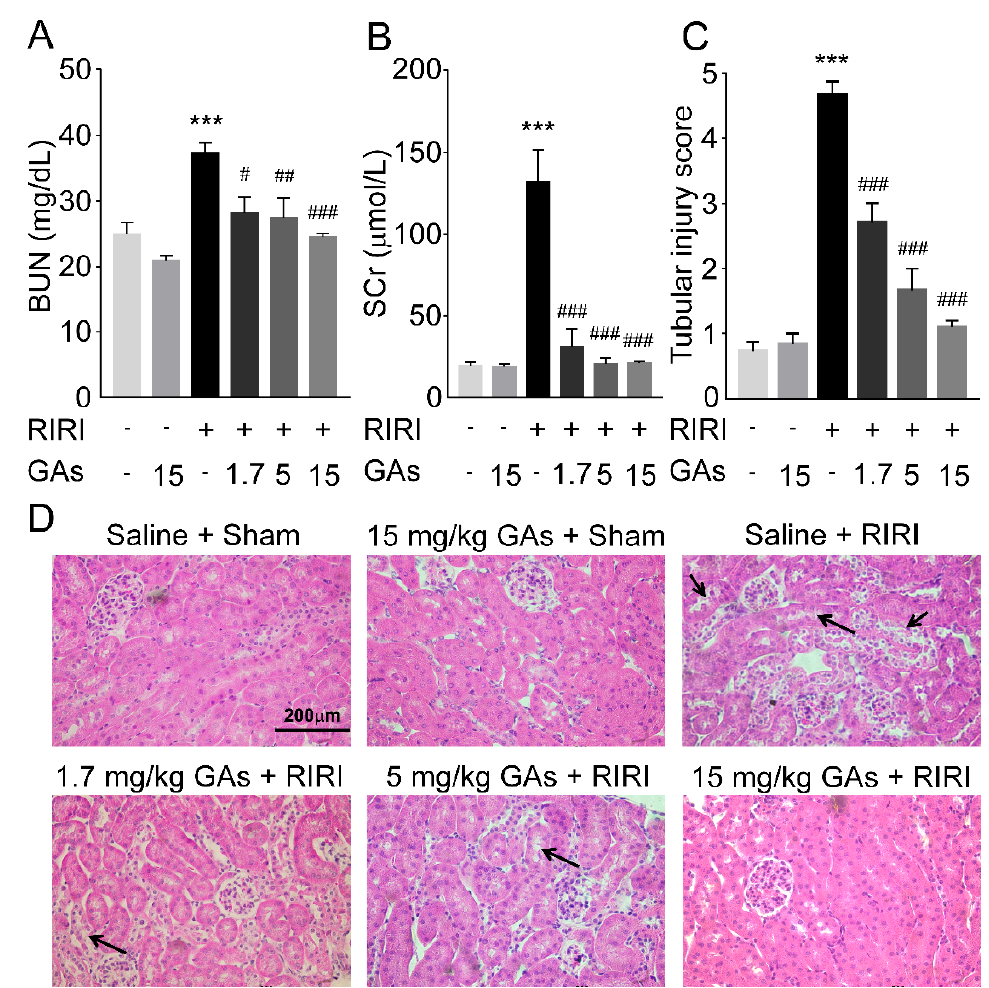
Figure 1. GAs protected the kidney against RIRI in mice. ( A ) Blood urea nitrogen. ( B ) Serum creatinine. Values are expressed as the mean ± SEM ( n = 6~8). ( C ) Quantification of tubular injury scores ( n = 8). ( D ) Representative H&E staining of renal tissue. (400 × original magnification, typical proximal tubular damages are indicated by black arrows). *** p < 0.001 compared with Saline + Sham group; # p < 0.05, ## p < 0.01 and ### p < 0.001 compared with Saline + RIRI group (two-tailed Student’s t -test).